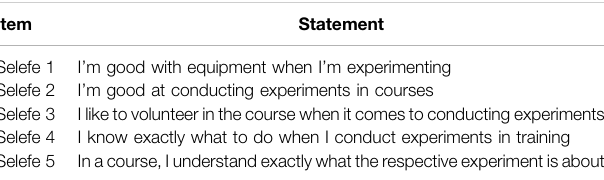
TABLE 3 | Scale for the pre-service teachers ’ self-ef fi cacy in conducting experiments